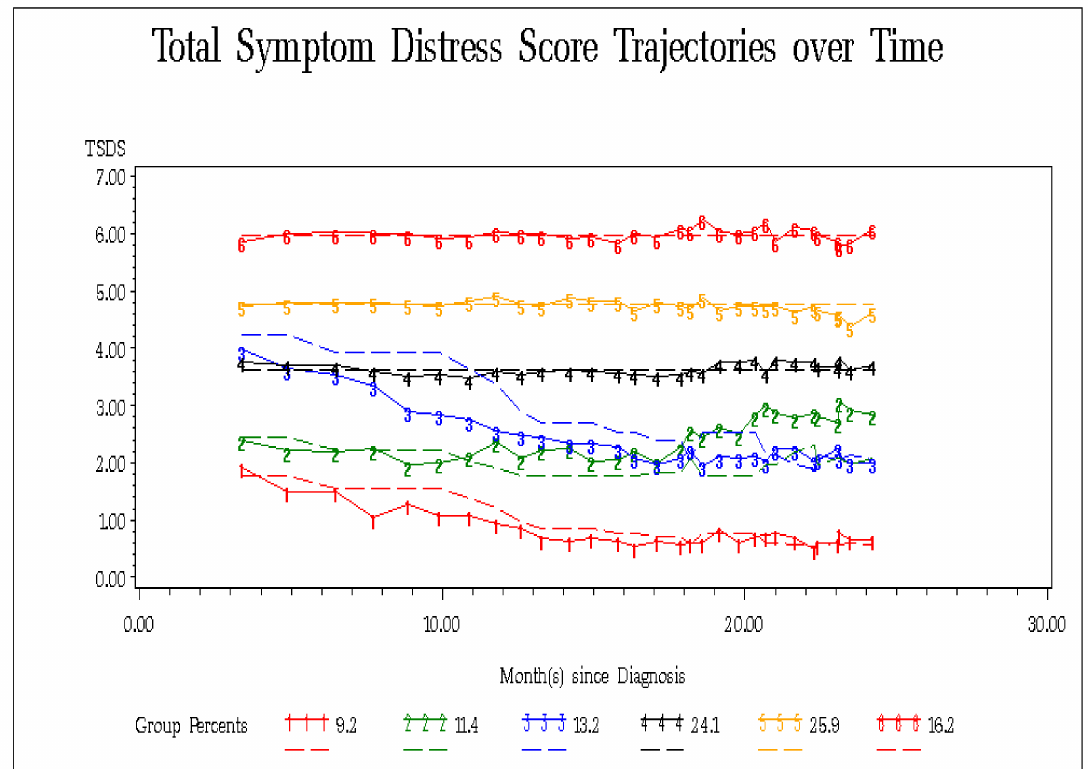
Figure 1. Total Symptom Distress Score (TSDS)* group trajectories over time. *Transformed values are reported. Magnitude of TSDS di ff erences within group trajectories are relative, and not absolute